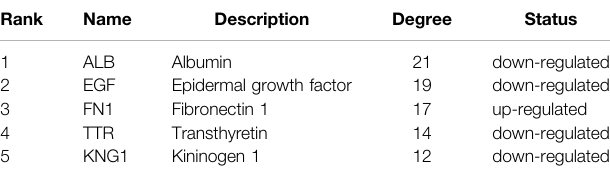
TABLE 1 | Top fi ve hub genes with a higher degree of